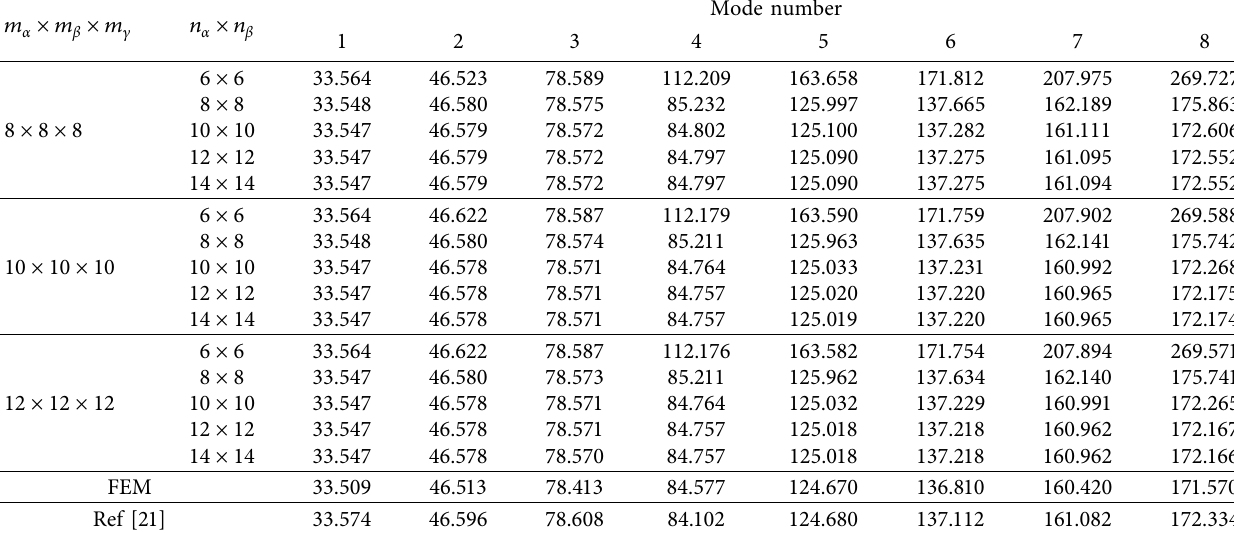
Table 2: The first eight natural frequencies of the strongly coupled plate-cavity system.